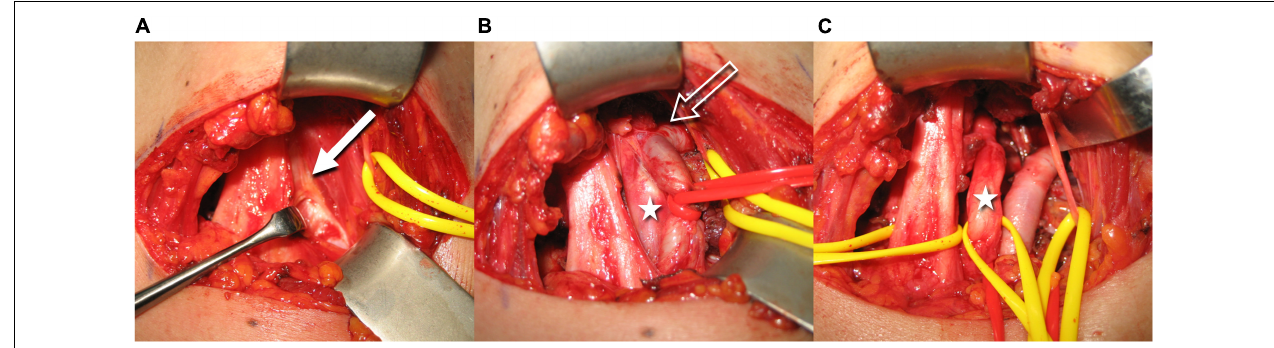
FIGURE 5 | Intraoperative images illustrate the resection steps of the accessory ligament (the left side of the images is dorsal, top is cranial, right is ventral, and bottom is caudal). The white arrow shows the fibrous ligament above the neurovascular bundle (A) . After partial excision, a section of the brachial plexus is visible (white star). The constriction of the subclavian artery becomes evident (void white arrow) (B) . After complete removal of the fibrous band, the neurovascular bundle is now fully mobilized (C) (Courtesy of Prof. O.